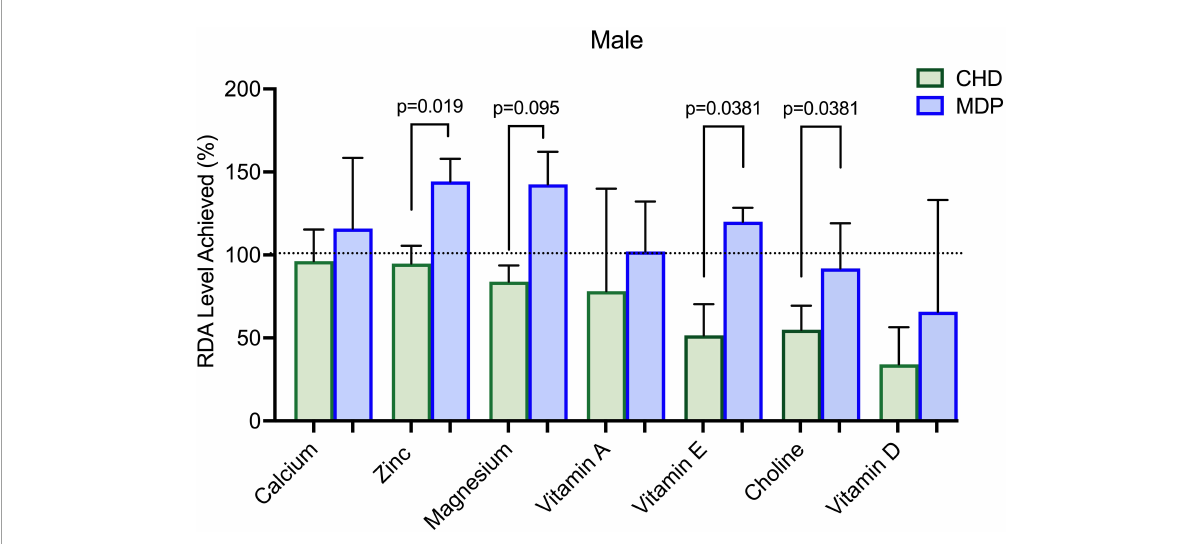
FIGURE4 Micronutrient intake of males compared to RDA for the Mediterranean diet pattern (MDP) and Canada’s Habitual Diet Pattern